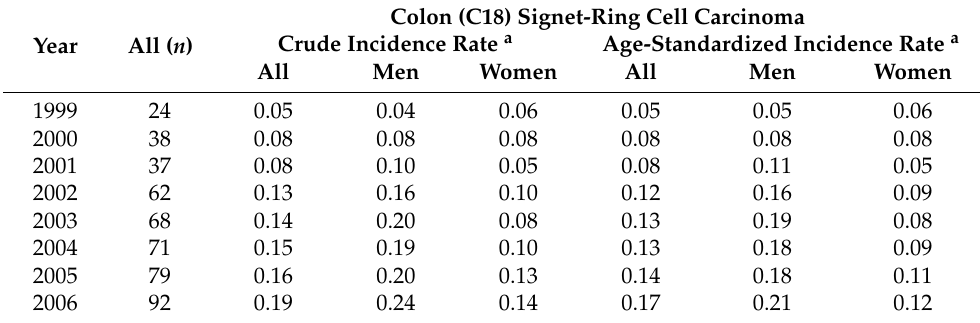
Table 1. Incidence of colon signet-ring cell carcinoma in South Korea between 1999 and 2017. Colon (C18) Signet-Ring Cell Carcinoma Crude Incidence Rate a Age-Standardized Incidence Rate a Year All ( n ) All Men Women All